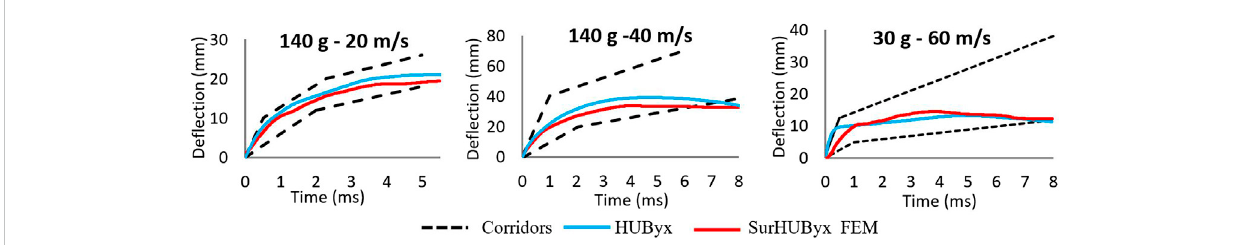
FIGURE 5 De fl ection time curves for the three cases of Bir impact.